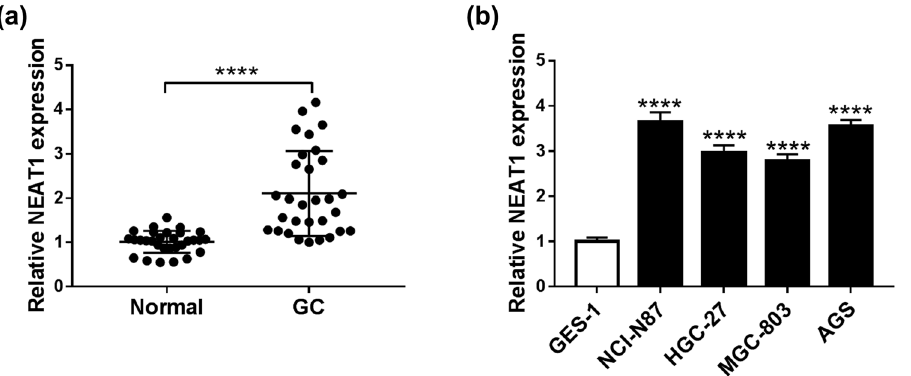
Figure 1: NEAT1 was up - regulated in GC tissues and cells. ( a and b ) QRT - PCR was utilized to examine the relative NEAT1 expression in GC tissues ( a ) and cells ( b ) . **** P <